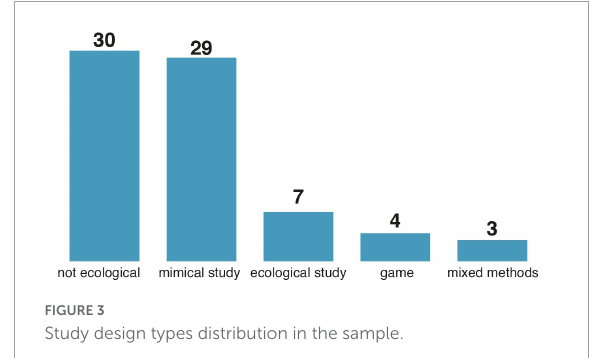
FIGURE3 Study design types distribution in the sample.